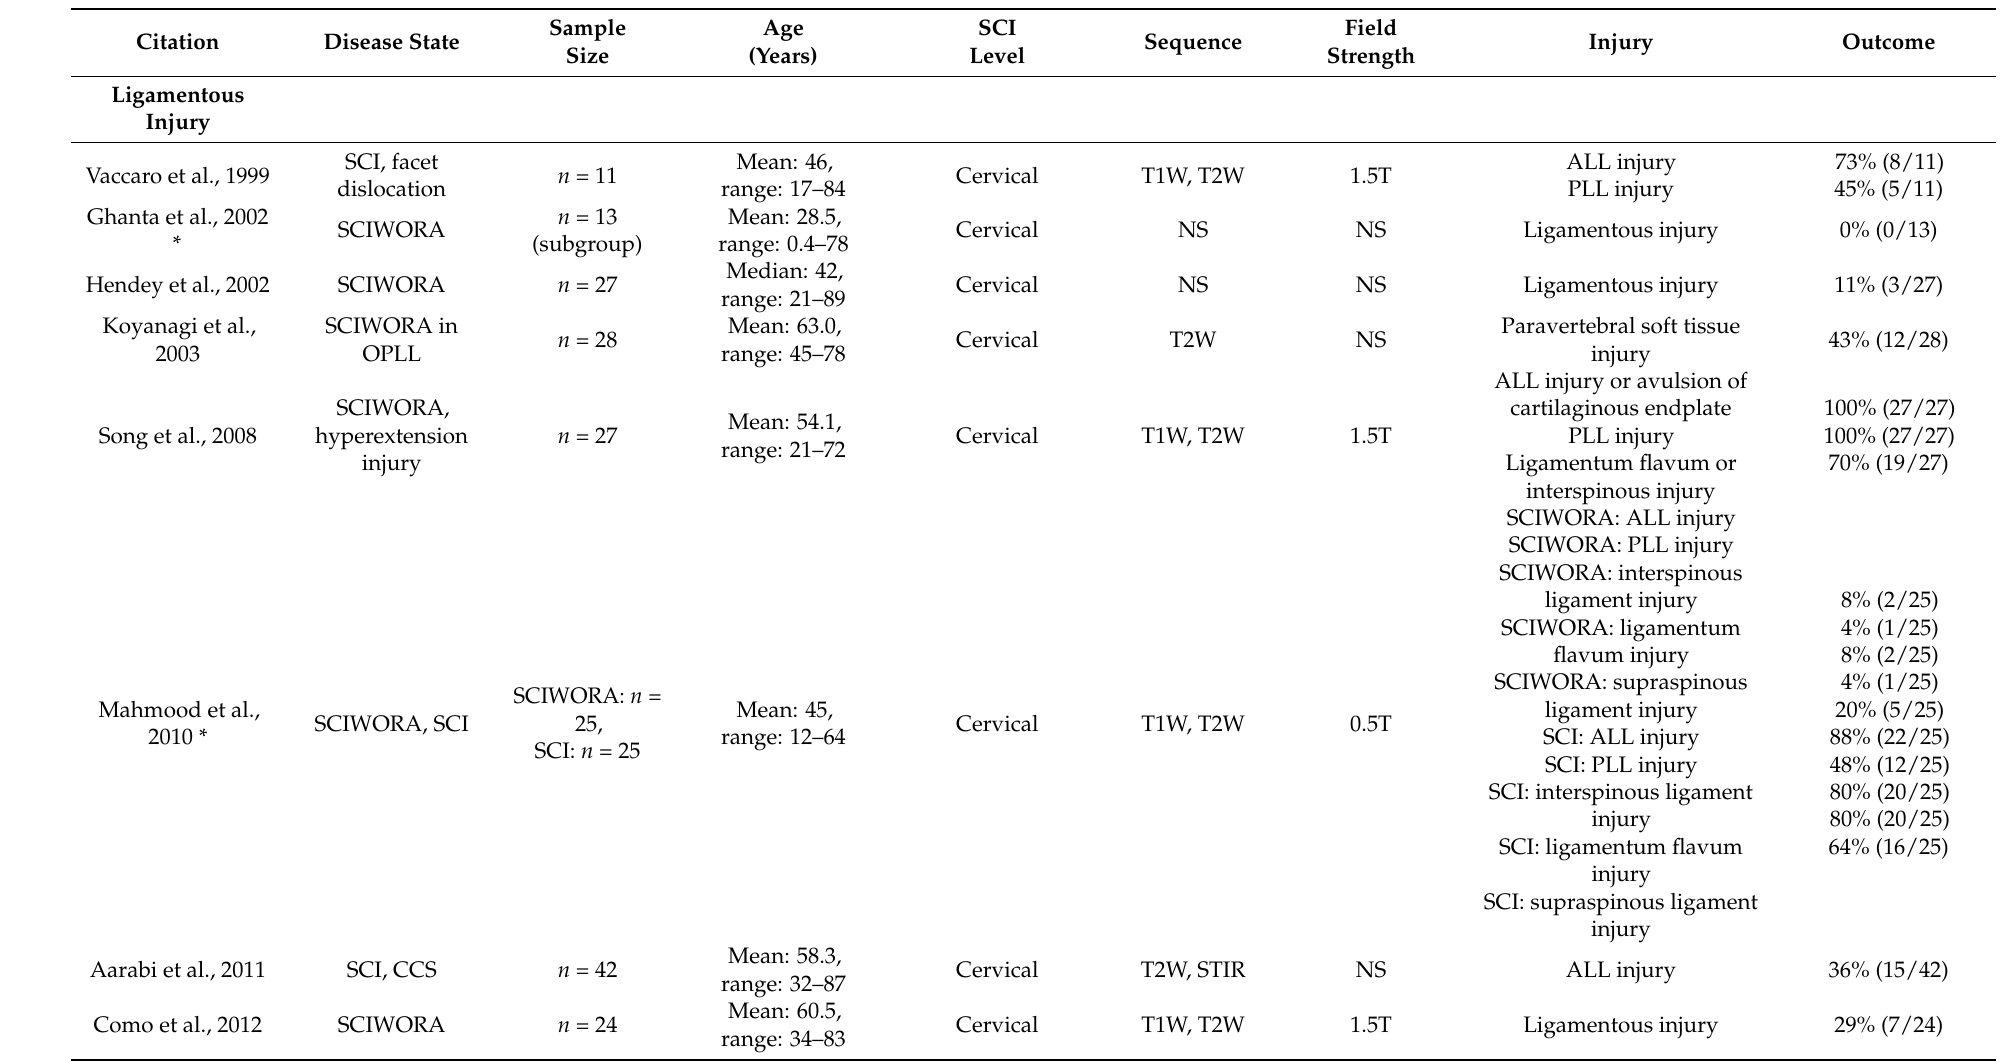
Table 4. Key Question 2: What is the frequency of abnormal MRI findings of specific features of spinal injury that are likely to alter clinical management in patients with acute SCI?